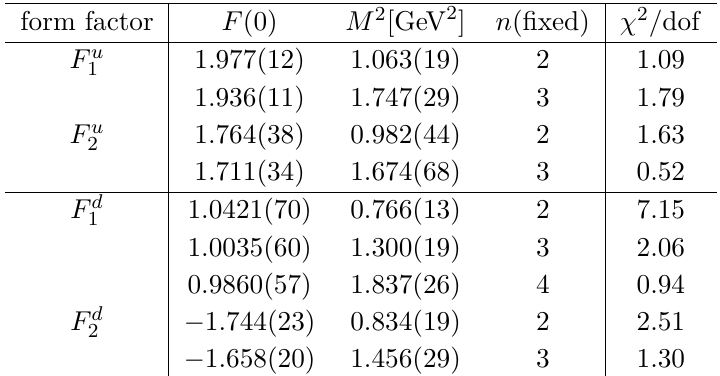
Table 13 . Results for the fit parameters F (0) and M 2 obtained from a fit on the data of the Pauli and Dirac form factors using the ansatz (5.16) with fixed n . The corresponding χ 2 / dof , which takes into account the complete covariance matrix, is also listed.